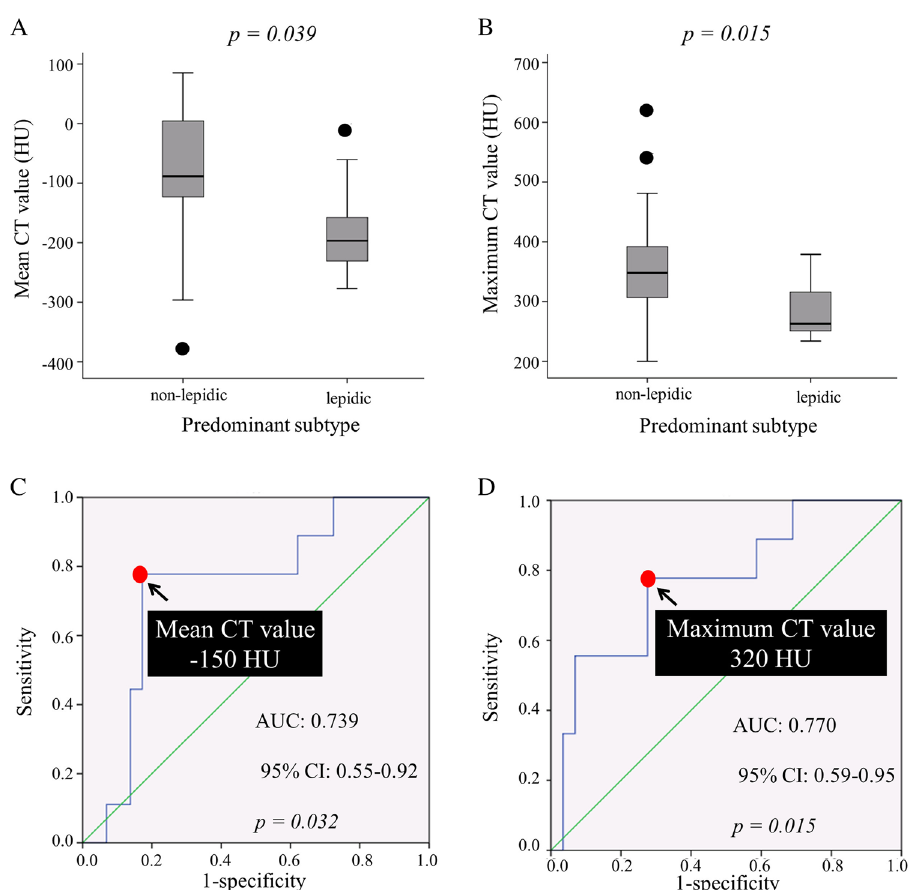
Figure 2. ( A , B ) Comparison of CT values between lepidic and non-lepidic predominant lesions. ( A ) Lepidic predominant lesions showed significantly lower mean CT values. ( B ) Lepidic predominant lesions showed significantly lower maximum CT values. ( C , D ) Receiver operating characteristic curve analysis for lepidic predominant lesion prediction. ( C ) The sensitivity and specificity of mean CT values were 77.8% and 82.8%, respectively. ( D ) The sensitivity and specificity of maximum CT values were 77.8% and 72.4%,